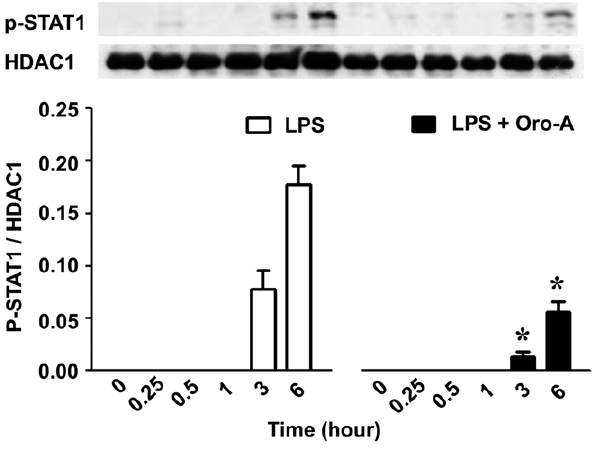
Figure 6. Oroxylin A inhibition of LPS-induced STAT1 activa- tion in BV-2 cells. BV-2 cells (2 6 10 6 cells/dish) were co-treated with LPS (100 ng/ml) and oroxylin A (Oro-A, 50 m M) for indicated time periods. Nuclear proteins were then isolated and subjected to Western blot analysis using specific antibodies against p-STAT1 and HDAC1. A representative Western blot is shown in upper panel and the ratio of p- STAT1 to HDAC1is calculated and shown in bottom panel. Results are expressed as means 6 SEM from three independent experiments. * , p , 0.05, Student’s t-test compared with corresponding LPS-treated cells.